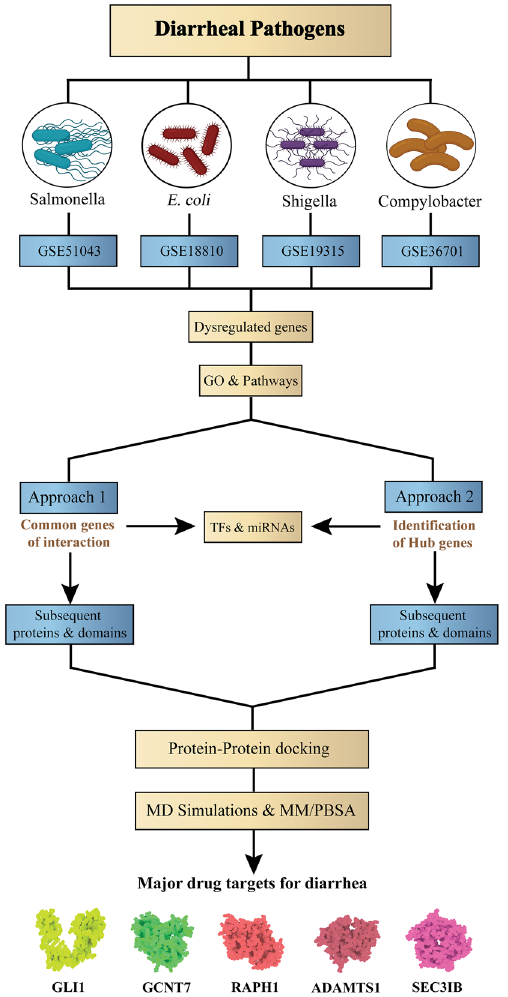
Figure 1. Schematic workflow of identifying the major druggable targets of diarrheal pathogens.